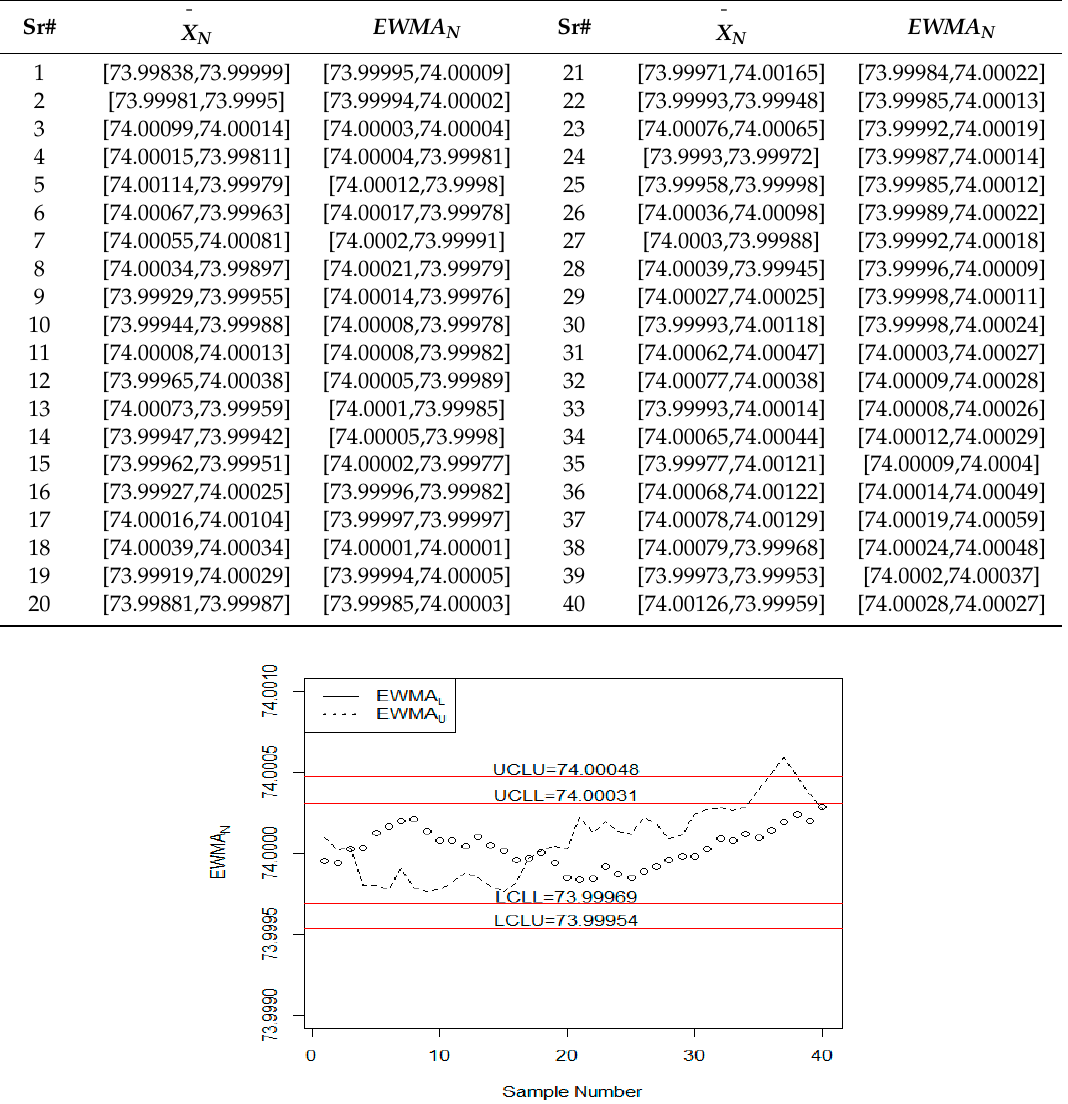
Table 6. The simulated neutrosophic data.